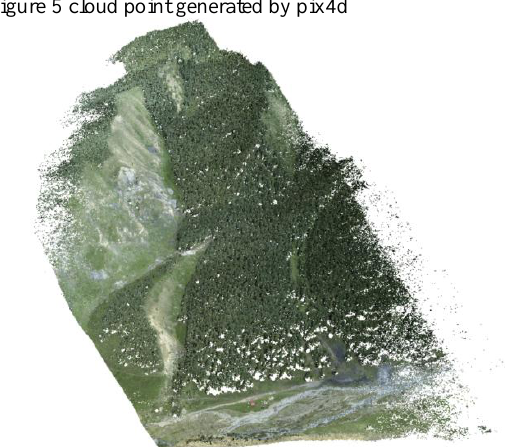
Figure 2. mosaic image of the whole area